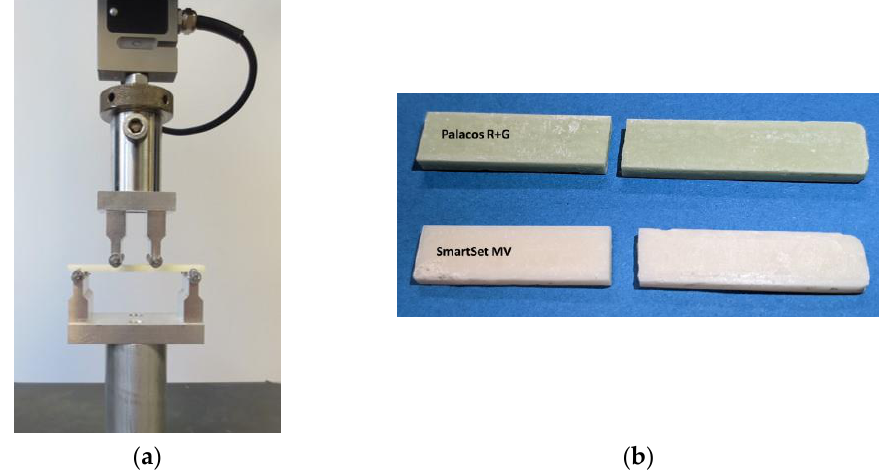
Figure 2. ( a ) Four-point bending test with integrated cement specimen; ( b ) specimen after the test-